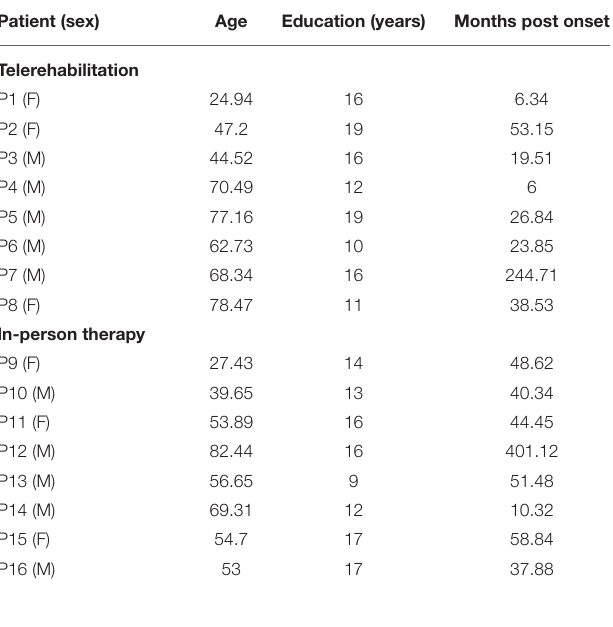
TABLE 1 | Demographic background of the bilingual adults with aphasia.